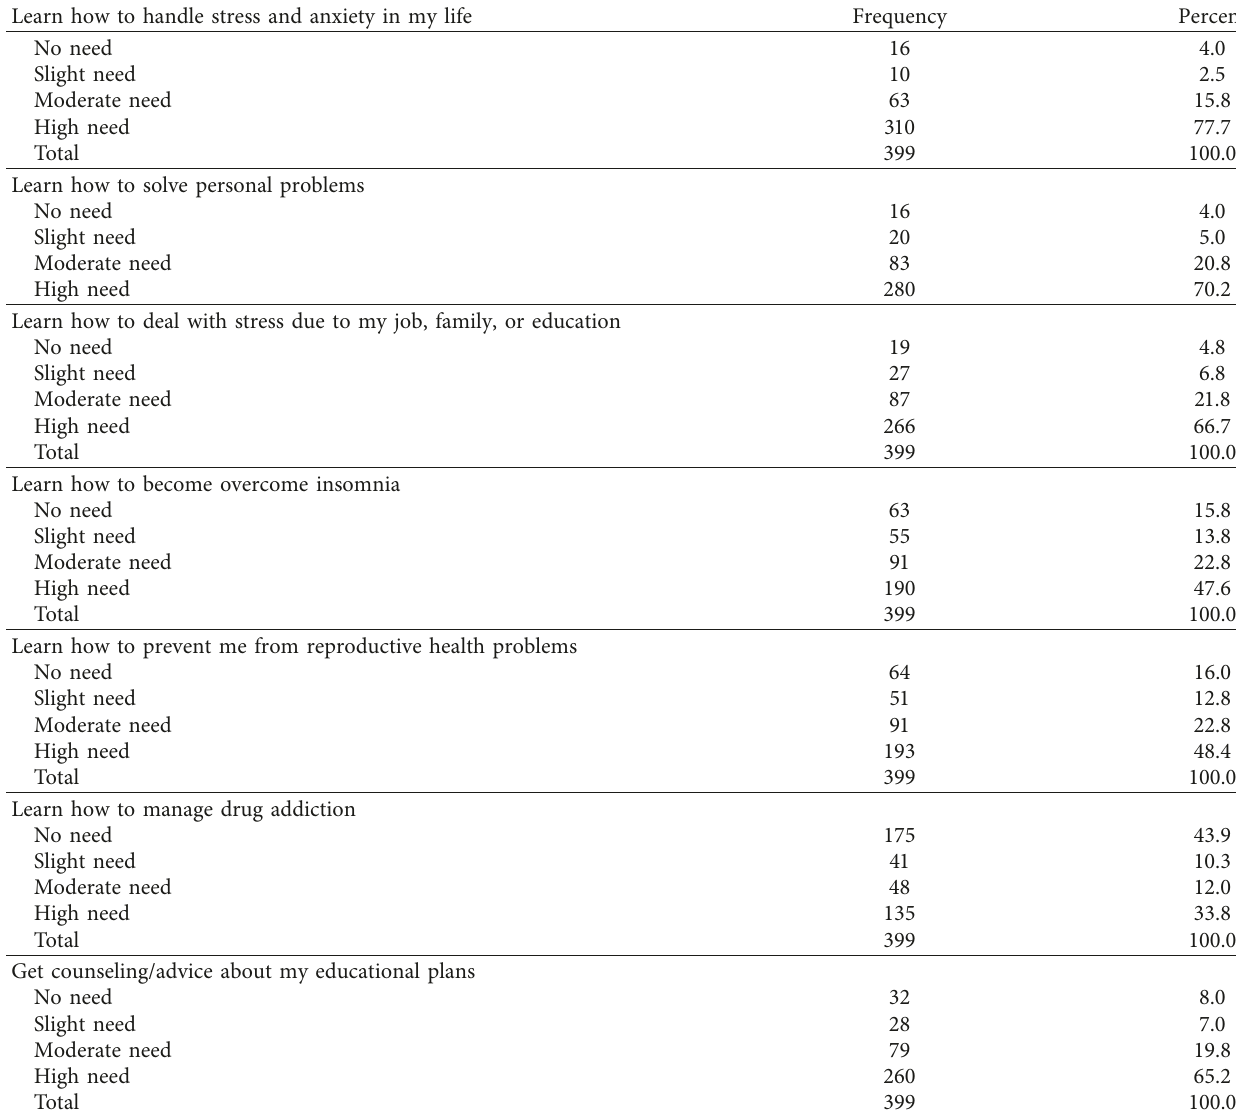
Table 6: Personal counseling need